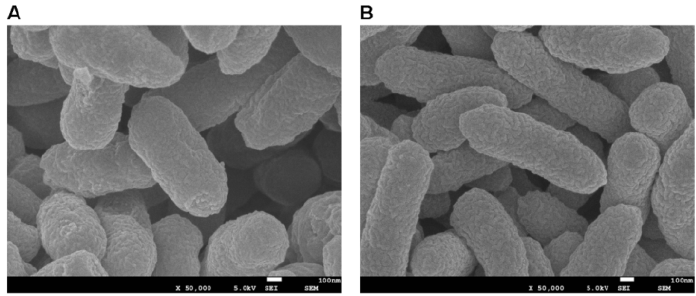
Figure 6. SEM images of P. shigelloides H5 without Cd 2+ stress ( A ) and with Cd 2+ stress ( B ).